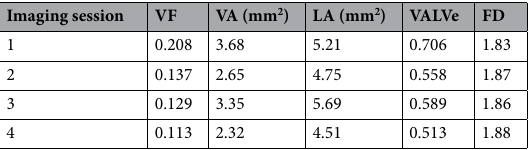
Imaging session